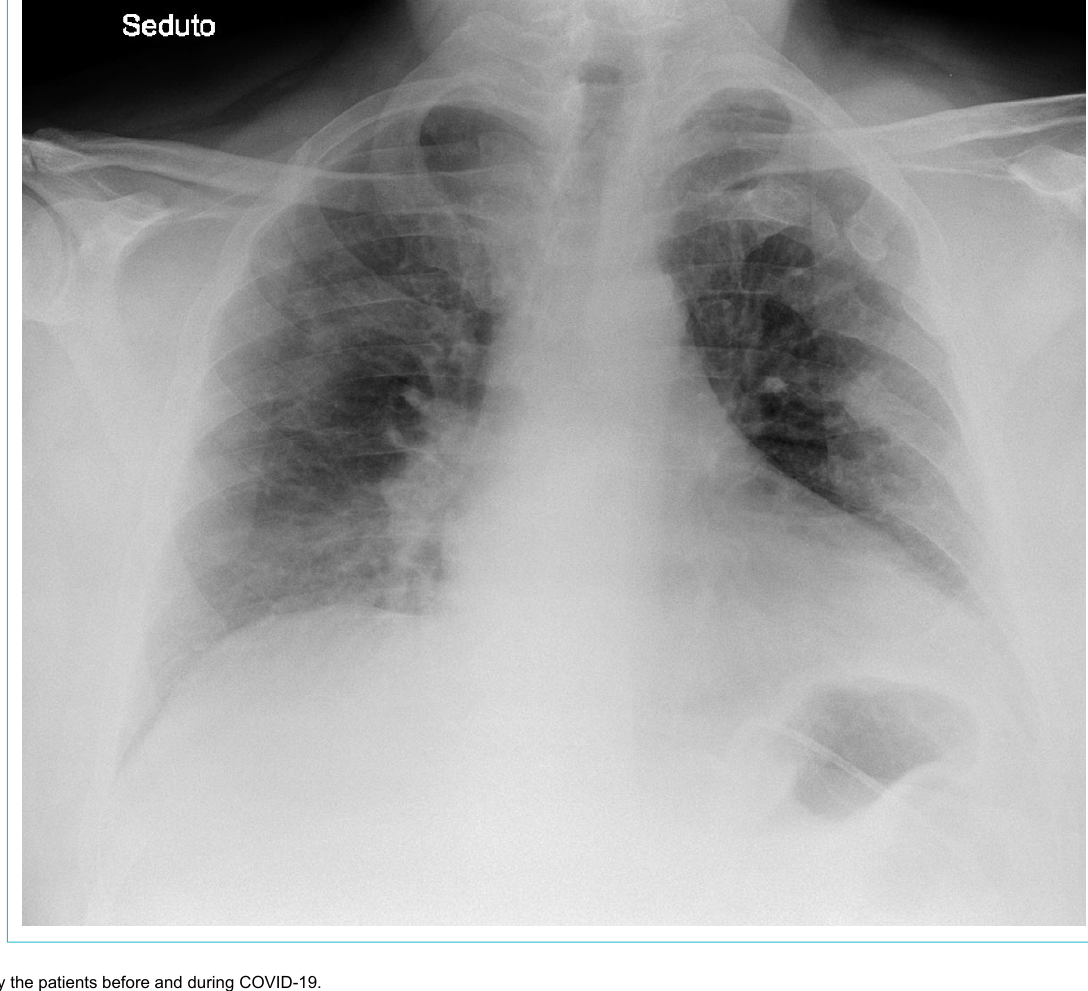
Table 1: Medications taken by the patients before and during COVID-19. Treatment